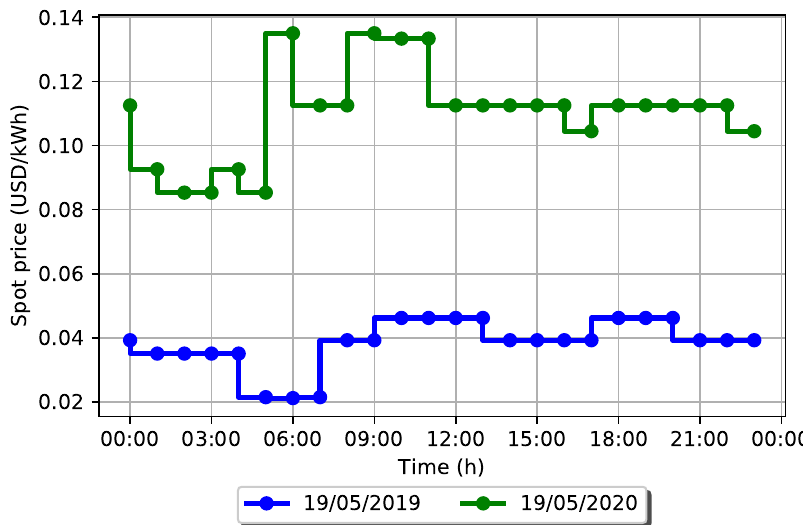
Figure 9. Colombian energy price difference between 19 May 2019 and 19 May